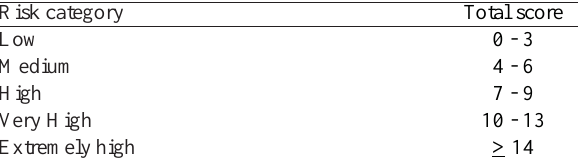
Table 2. Risk category according to the score